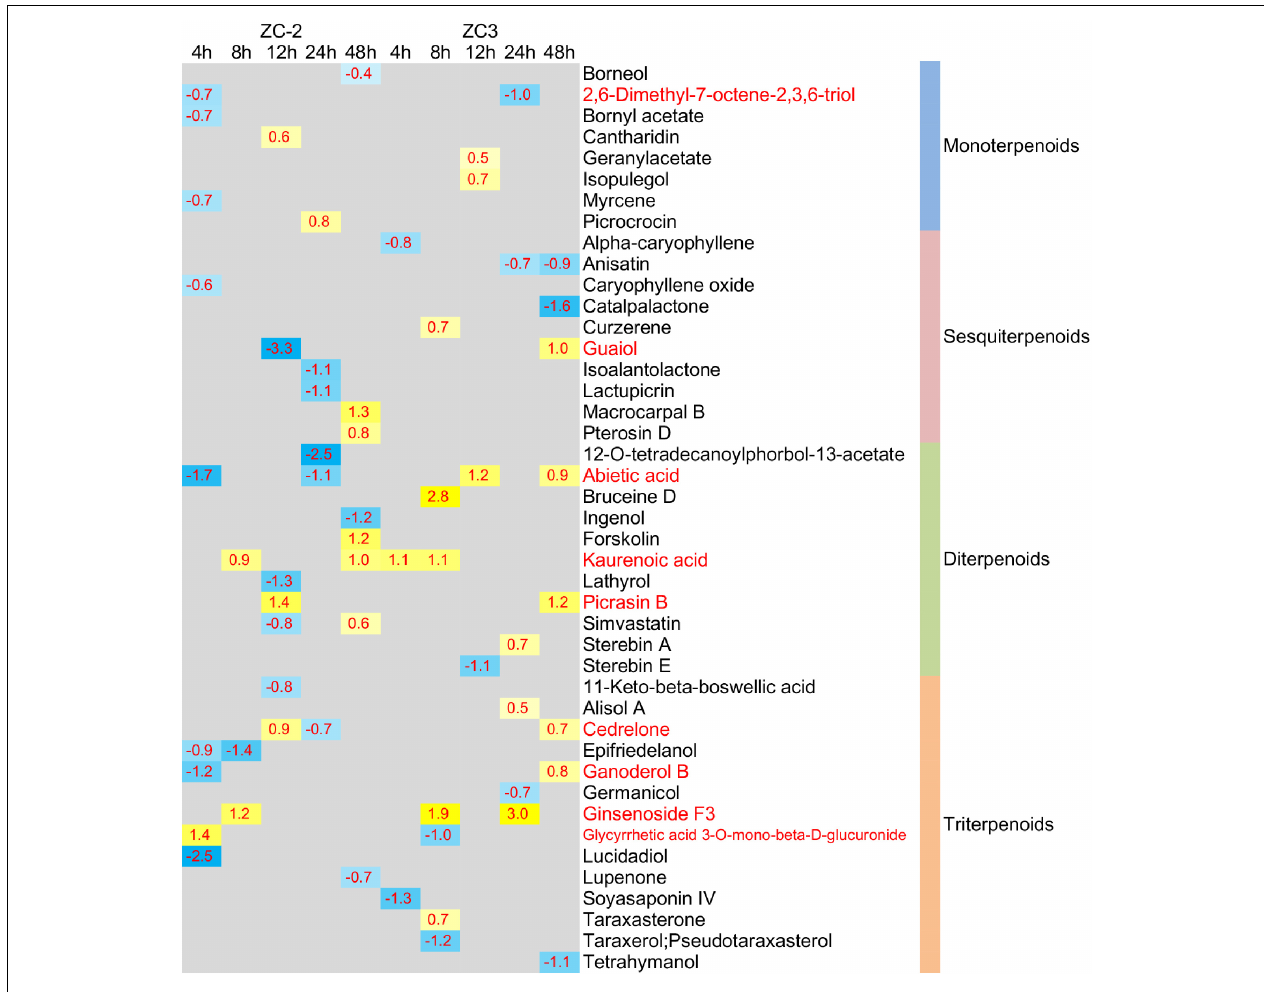
FIGURE 11 | Heatmap of the significantly differentially accumulated terpenoid compounds. The log 2 expression fold change is color-coded in each box: yellow indicates up-regulated compounds and blue indicates down-regulated compounds. Each row represents a terpenoid compound with its classification; the columns represent each sampling time point [4, 8, 12, 24, and 48 h post-inoculation (HPI)] for ZC-2 and